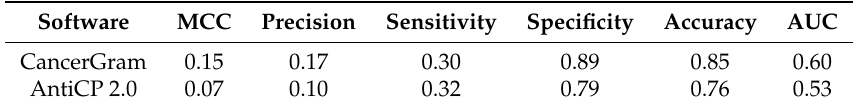
Table 4. Comparison of CancerGram and AntiCP 2.0 [13] performance on the independent data set. AntiCP 2.0 predictions were obtained using model 1 of the standalone version with default values of threshold (0.5) and window length (10). CancerGram predictions were binarized. The low values of the Matthews correlation coefficient (MCC), precision and sensitivity are due to the large number of AMPs (769) and low number of ACPs (57) in the independent data set.